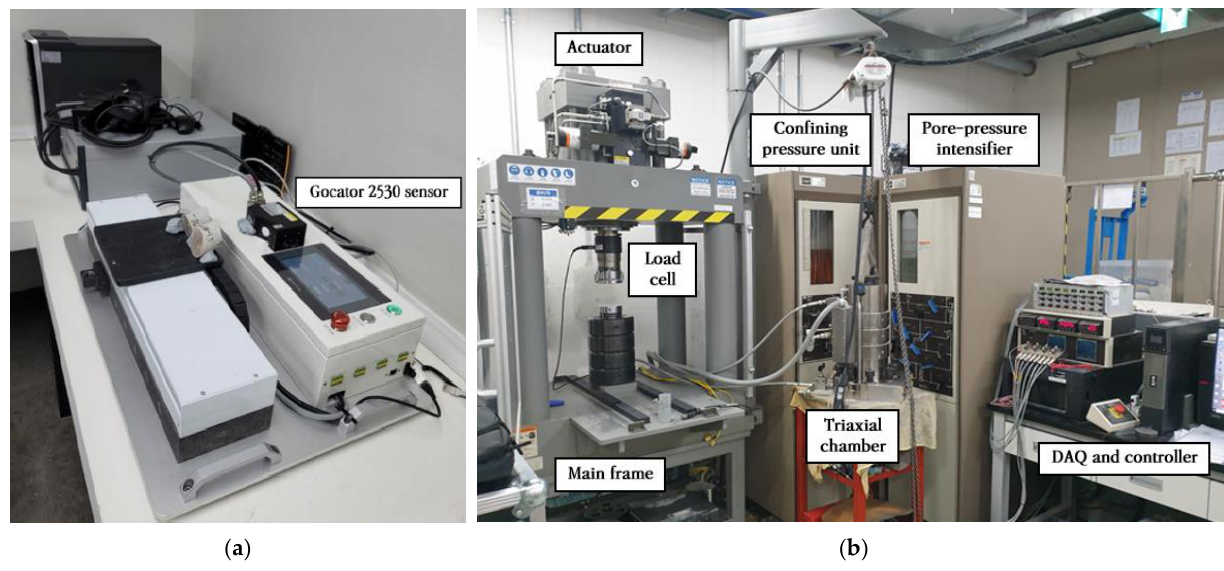
Figure 9. Test equipment used to investigate the applicability of the proposed technique: ( a ) 3-D laser scanning device; ( b ) MTS 816 system.